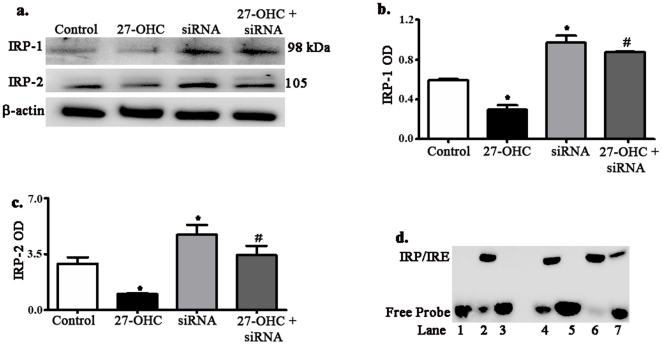
Reduction in iron-regulatory protein levels by 27-OHC is prevented by siRNA to gadd153.While treatment with 27-OHC reduces levels of IRP-1 and IRP-2, siRNA to gadd153 reverses the effects of 27-OHC on IRP-1 and IRP-2 levels (a–c). REMSA assay shows a clear shift in bands resulting from binding of IRP to IRE in control (line 4) as well as in gadd153 siRNA alone- treated slices (line 6). No shift in band was observed in the slices treated with 27-OHC alone (line 5) demonstrating that 27-OHC inhibits binding of IRP to IRE. Treatment with siRNA to gadd153 in presence of 27-OHC causes a band shift indicating that siRNA to gadd153 partially, but significantly, restores the binding of IRP to IRE (line 7). Lanes 1–3 – positive controls; lane 1 - biotin labeled IRE probe, lane 2 - biotin labeled IRE probe+cytosolic liver extract, lane 3 - biotin labeled IRE probe+cytosolic liver extract+200 fold molar excess of unlabeled IRE RNA. *p<0.05 versus controls; #p<0.05 versus 27-OHC.